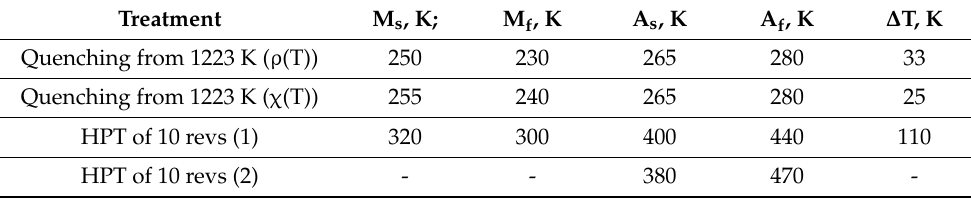
Table 2. Critical temperatures at the start (M s , A s ) and end (M f , A f ) of the TMT in the alloy Cu–14Al– 3Ni after different treatments (see Figure 8a and curves 1, 2 in Figure 8b). Treatment M s , K; M f , K A s , K A f , K ∆ T, K Quenching from 1223 K ( ρ (T))